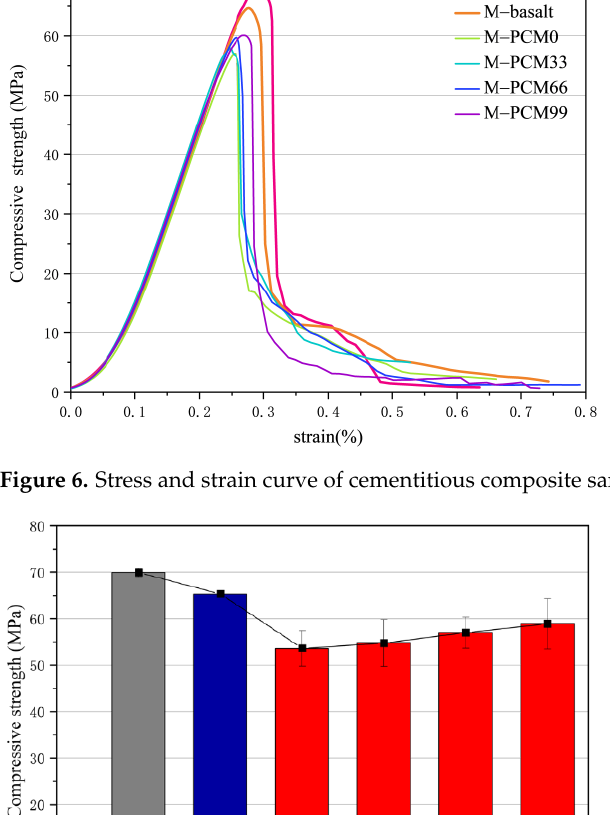
Figure 6. Stress and strain curve of cementitious composite samples under compression for 28 days.